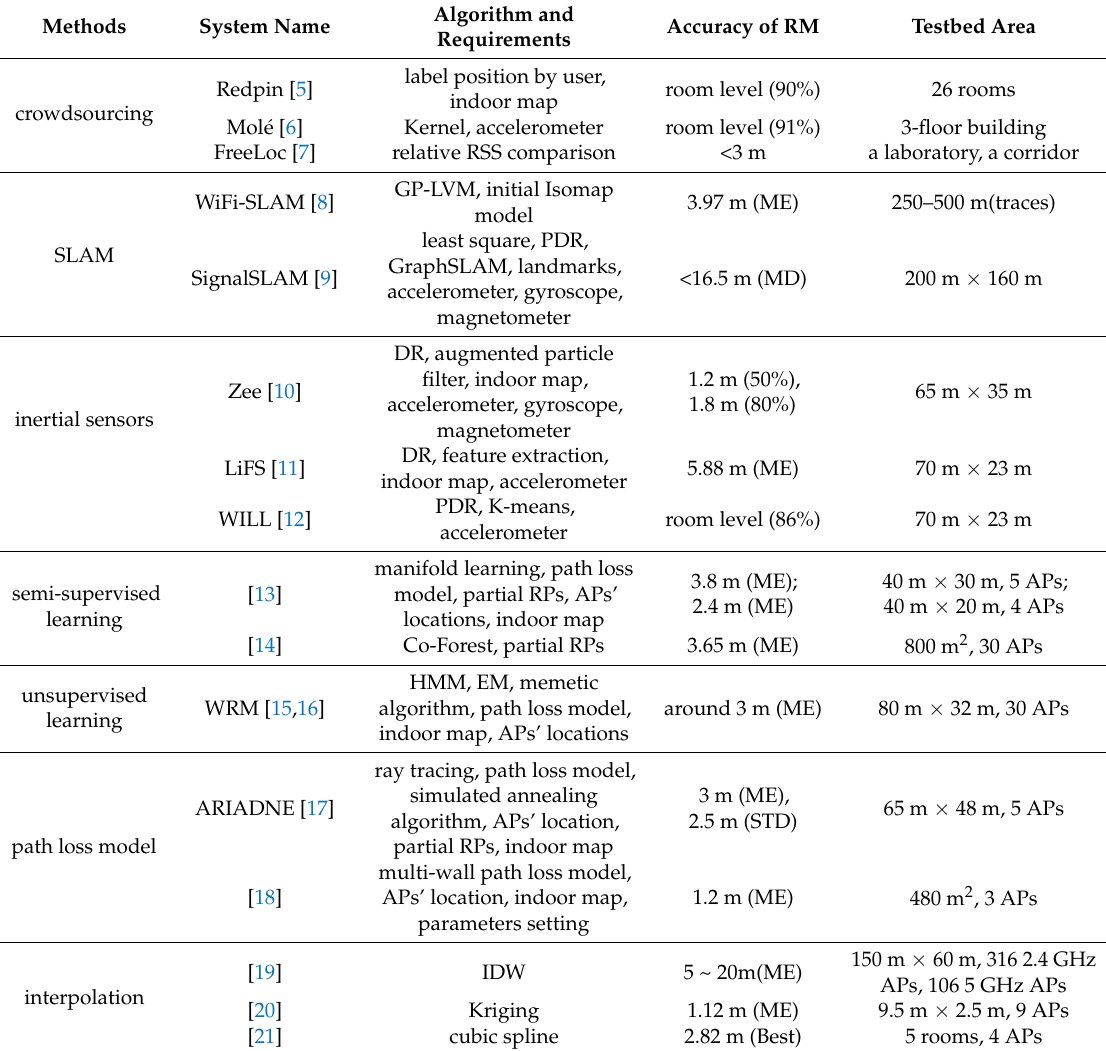
Table 1. Comparisons of different methods for radio map